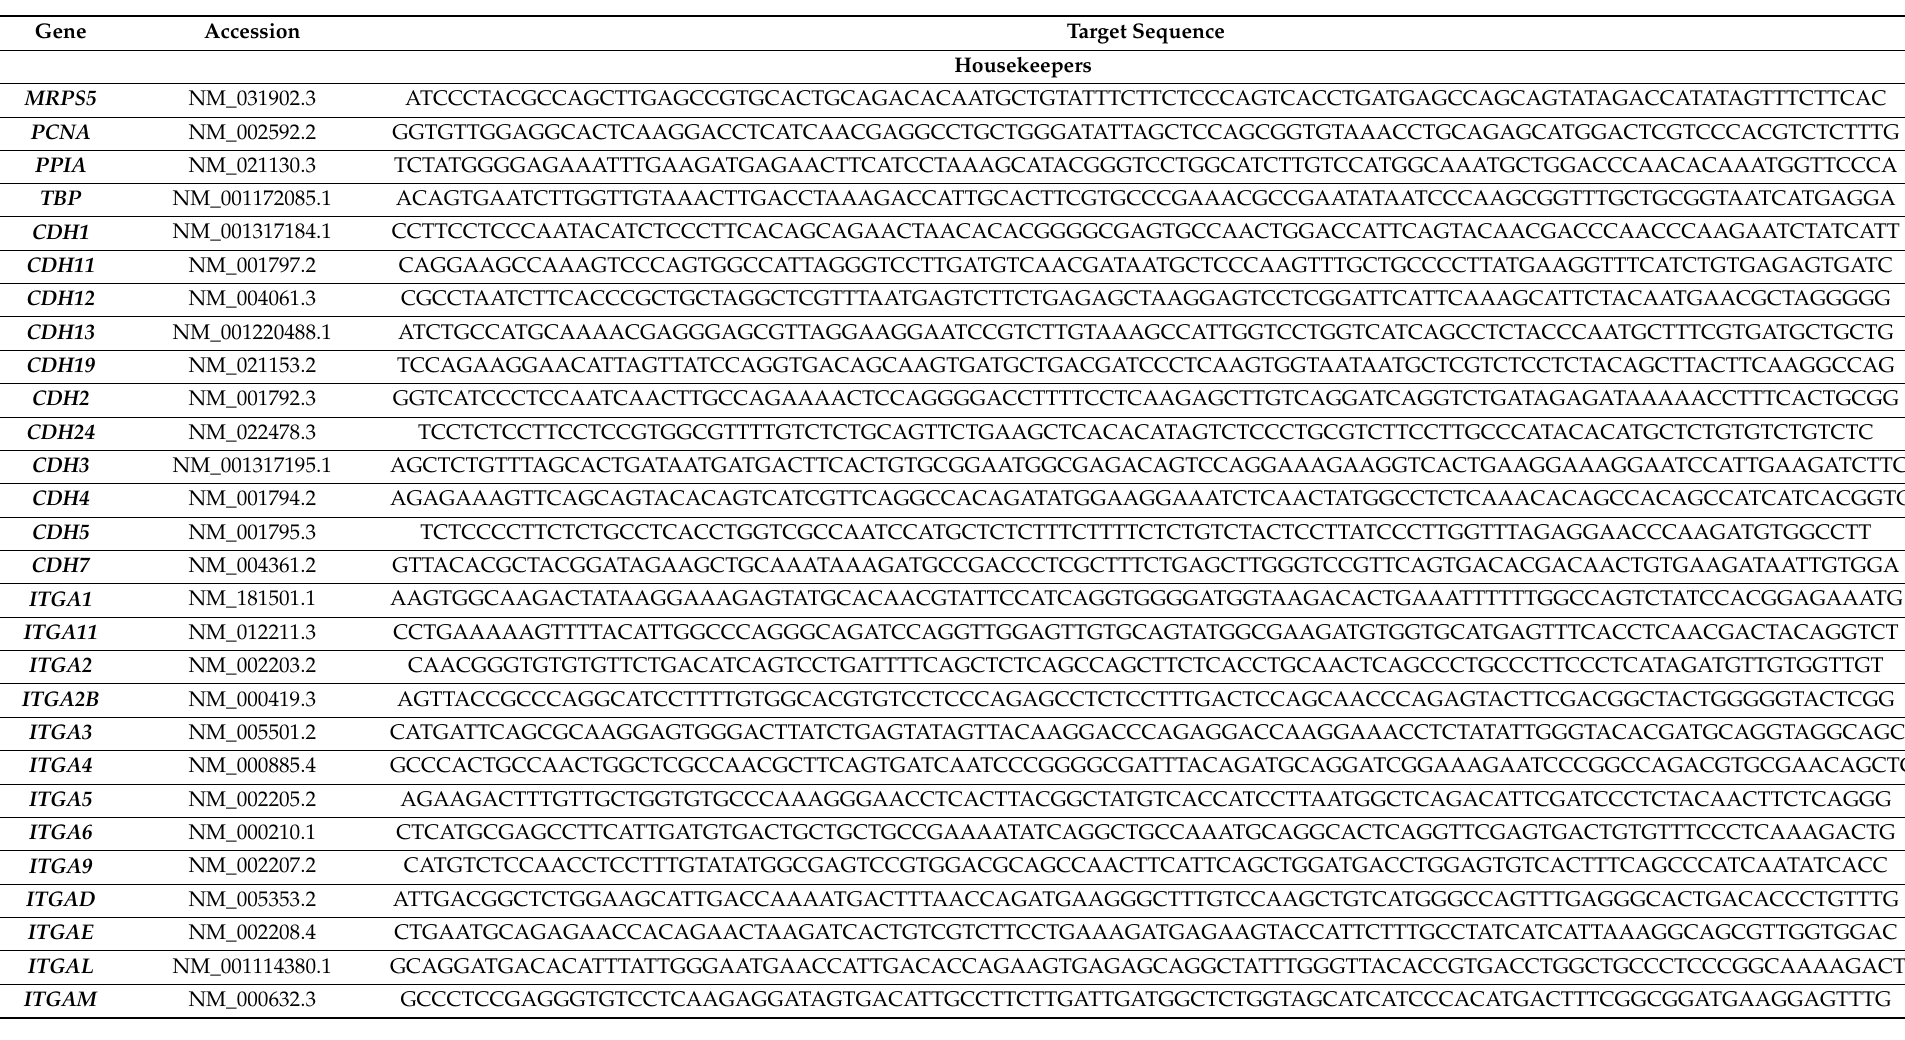
Table 1. NanoString gene expression of adhesion molecules. Table shows the respective gene of interest, the NCBI accession number and the target gene sequence detected. The top 4 genes in the table are house-keeping genes. The remainder are key integrin family members and